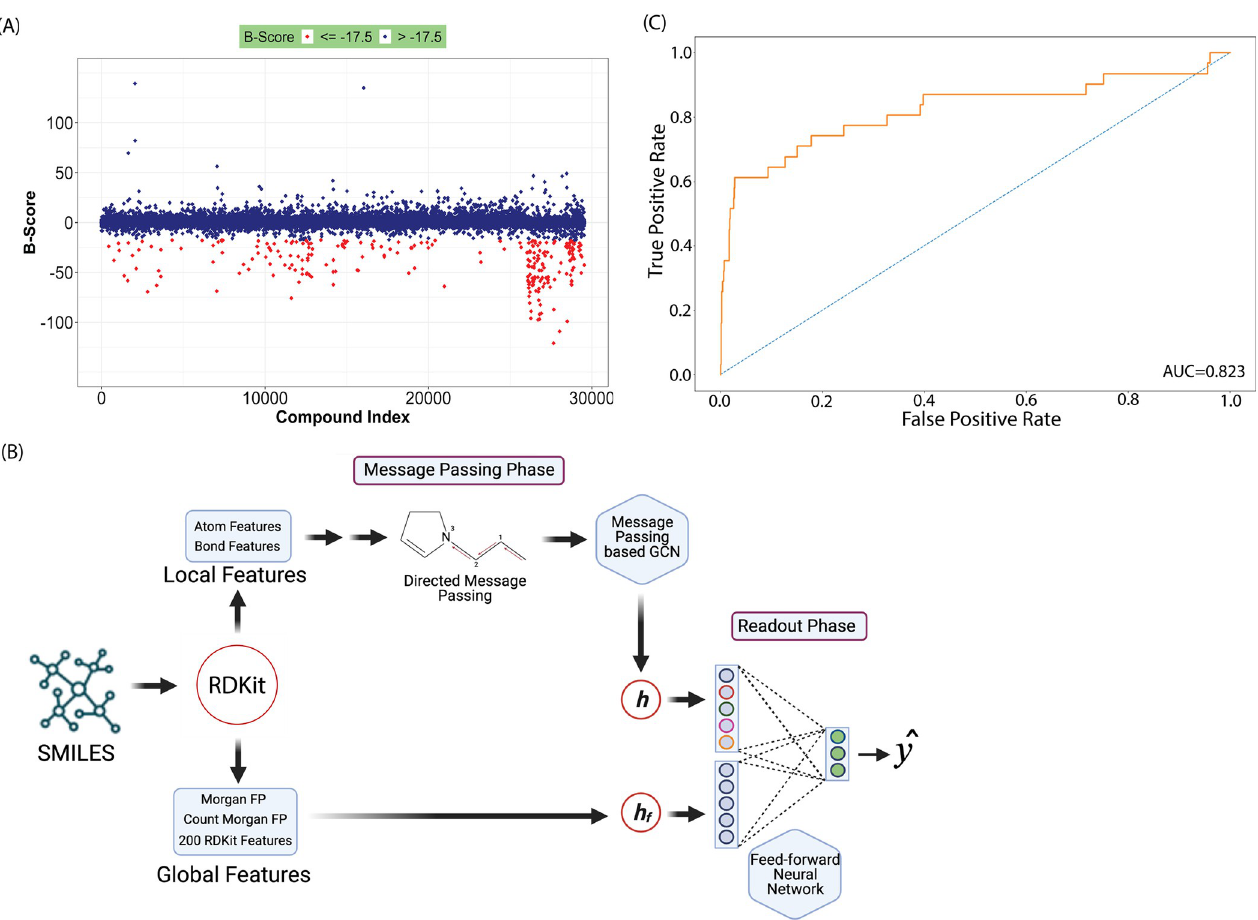
Fig 1. Initial training and performance evaluation of the machine learning model. (A) High-throughput screening data generated by screening a compound library of 29,537 compounds against B . cenocepacia K56-2 wild-type. Using B-score � -17.5 as a threshold, the screening yielded 256 active compounds. Dark blue and red represent inactive and active compounds, respectively. (B) The machine learning model was trained using a D-MPNN approach, which extracts compounds’ local features, such as atom and bond features. The model was fed more than 200 additional global molecular descriptors to further increase the accuracy. Dataset was split into 80:10:10 ratio to train, validate and test the model. (C) ROC-AUC plot evaluating model performance after training. The model attained a ROC-AUC of 0.823. Parts of panel B are modified from Yang et al . [11]. Fig 1B was created with https://biorender.com/.